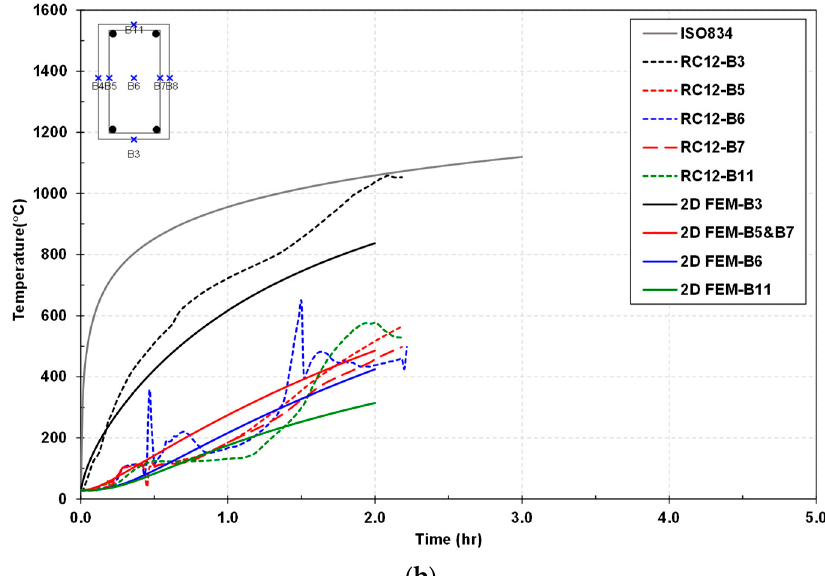
Figure 14. Comparison between prediction and testing of RC12 beams. ( a ) Reinforcements; ( b ) concrete.